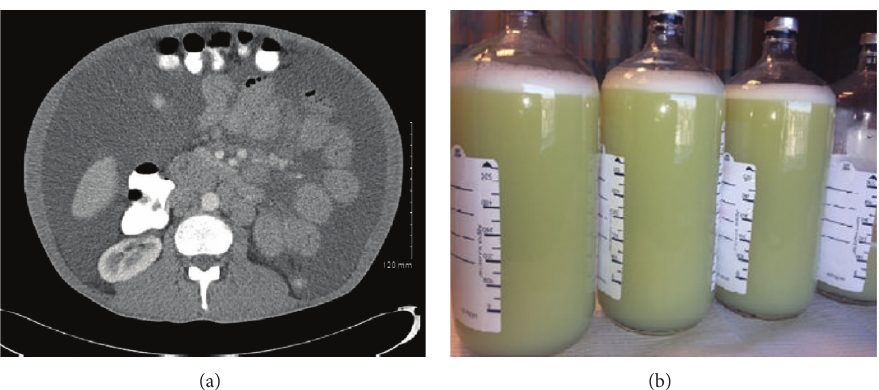
Figure 1: (a) Contrast CT of abdomen and pelvis showing extensive ascites with mesenteric and retroperitoneal lymphadenopathy. (b) Gross specimen of paracentesis showing thick pale yellowish chylous